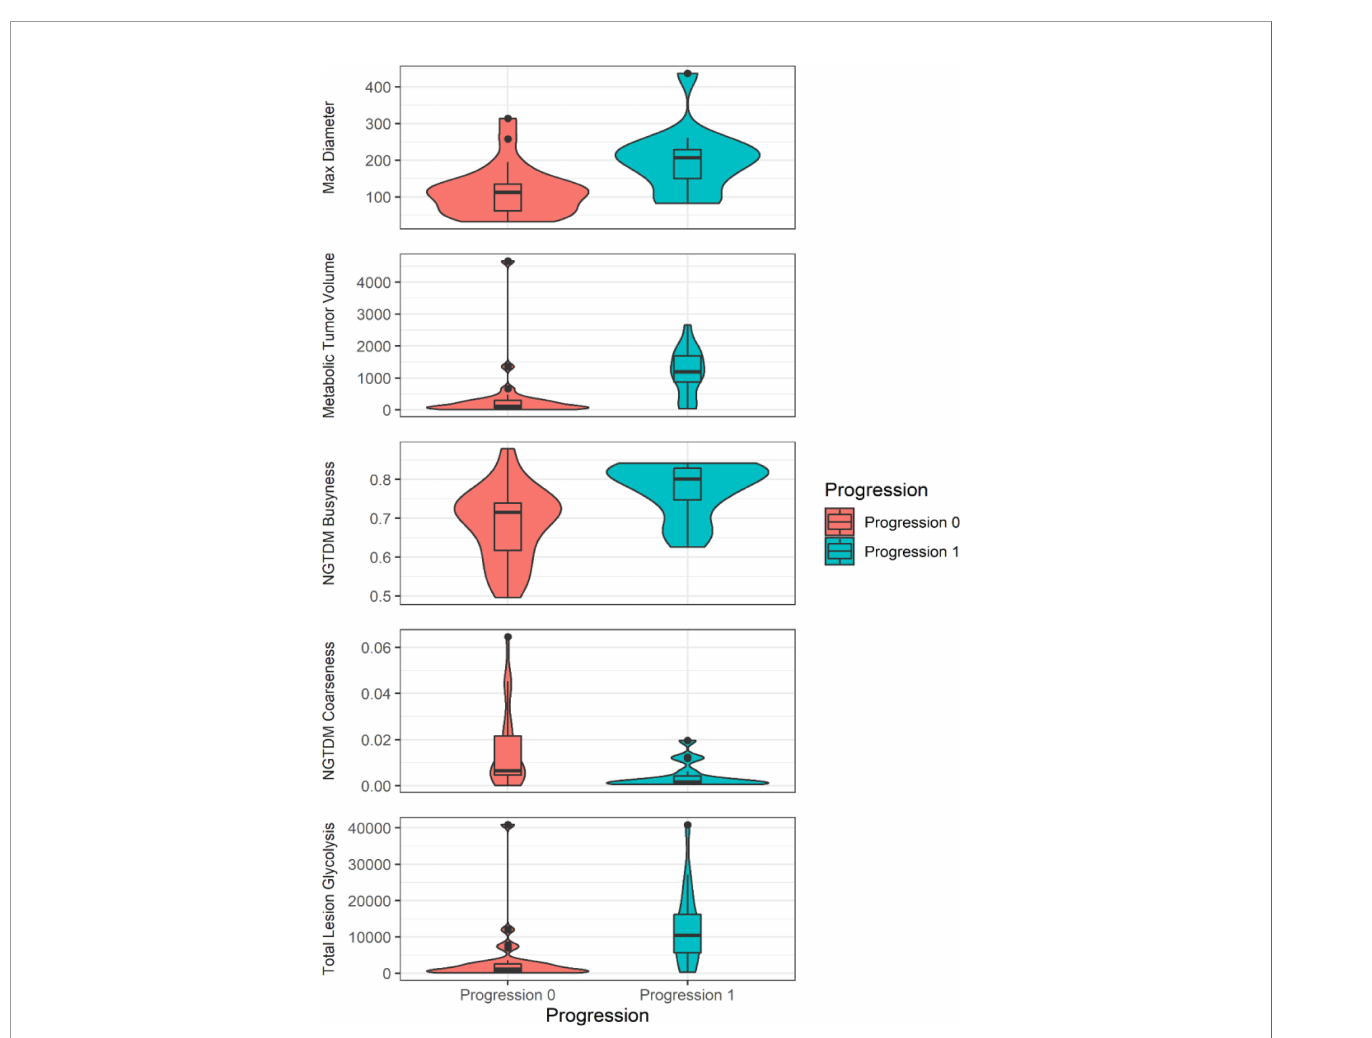
FIGURE 2 | The violin plot (R: A Language and Environment for Statistical Computing, version 4.04., using package ggplot2, version 3.3.3) shows the values of the prominent features to predict 2-year event-free